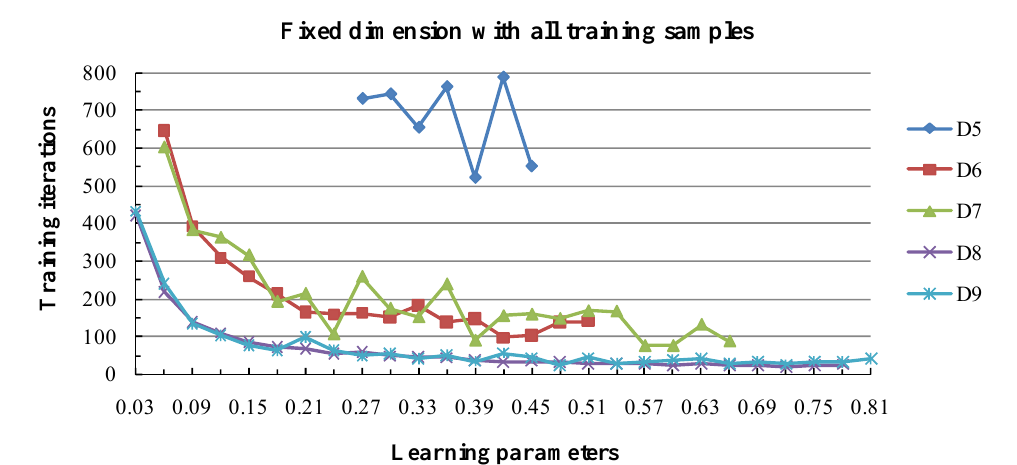
Fixed dimension with all training